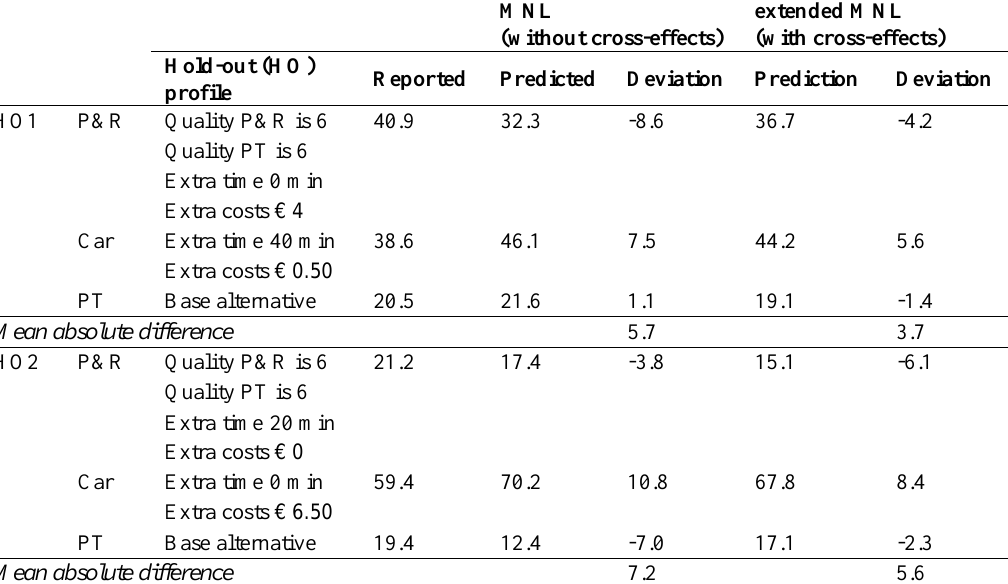
Table 5. Predictions of modal splits for the holdouts choice sets by both the model without cross-effects and the model including cross-effects for the Nijmegen